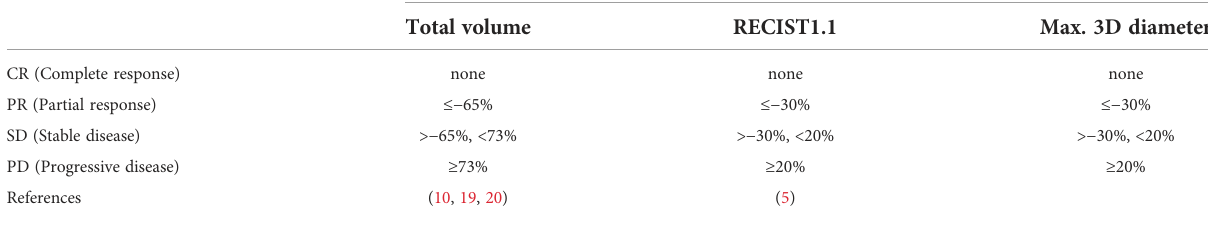
TABLE 2 Summary of the response criteria.